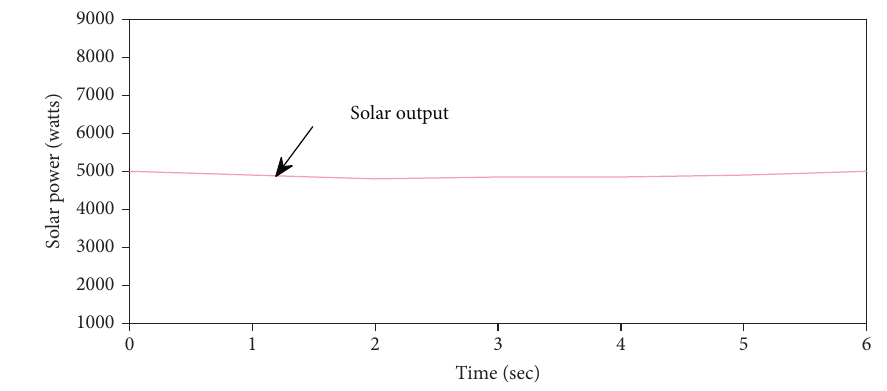
Figure 2: Solar panel output.